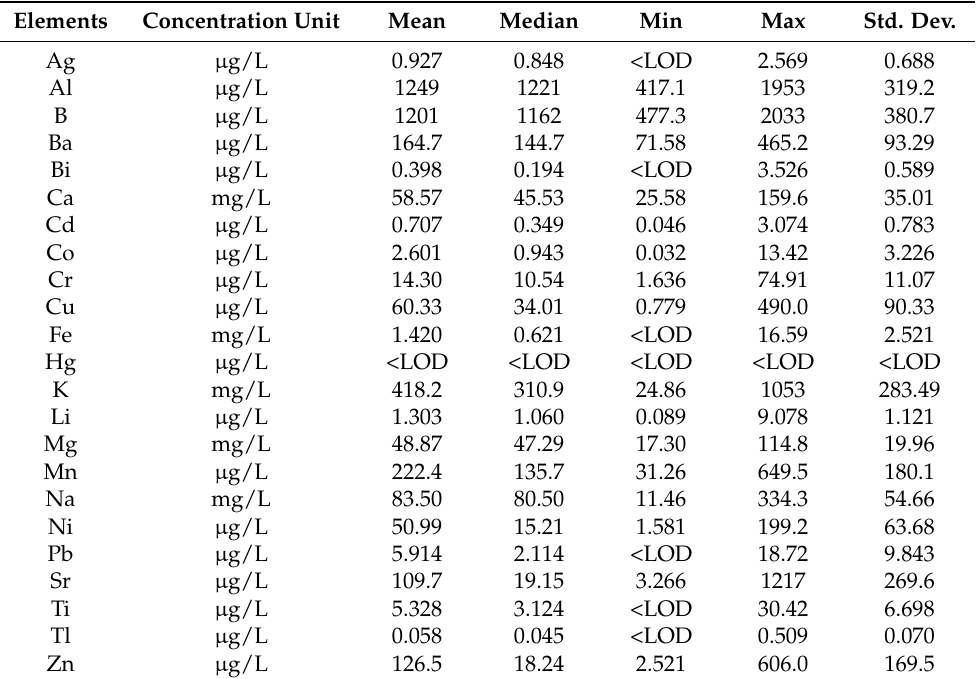
Table 4. Contents of selected elements in the measured cider samples and low-percentage alcoholic beverages (n = 73) [ µ